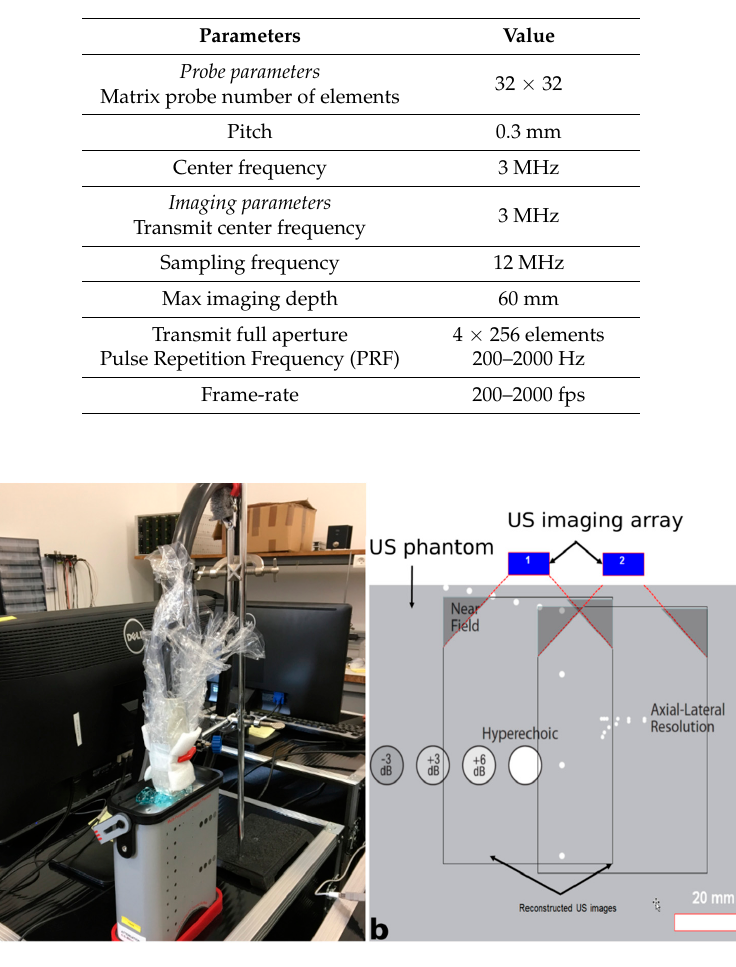
Figure 2. ( a ) Validation setup on a standard cyst phantom; ( b ) The diagram of the standard phantom